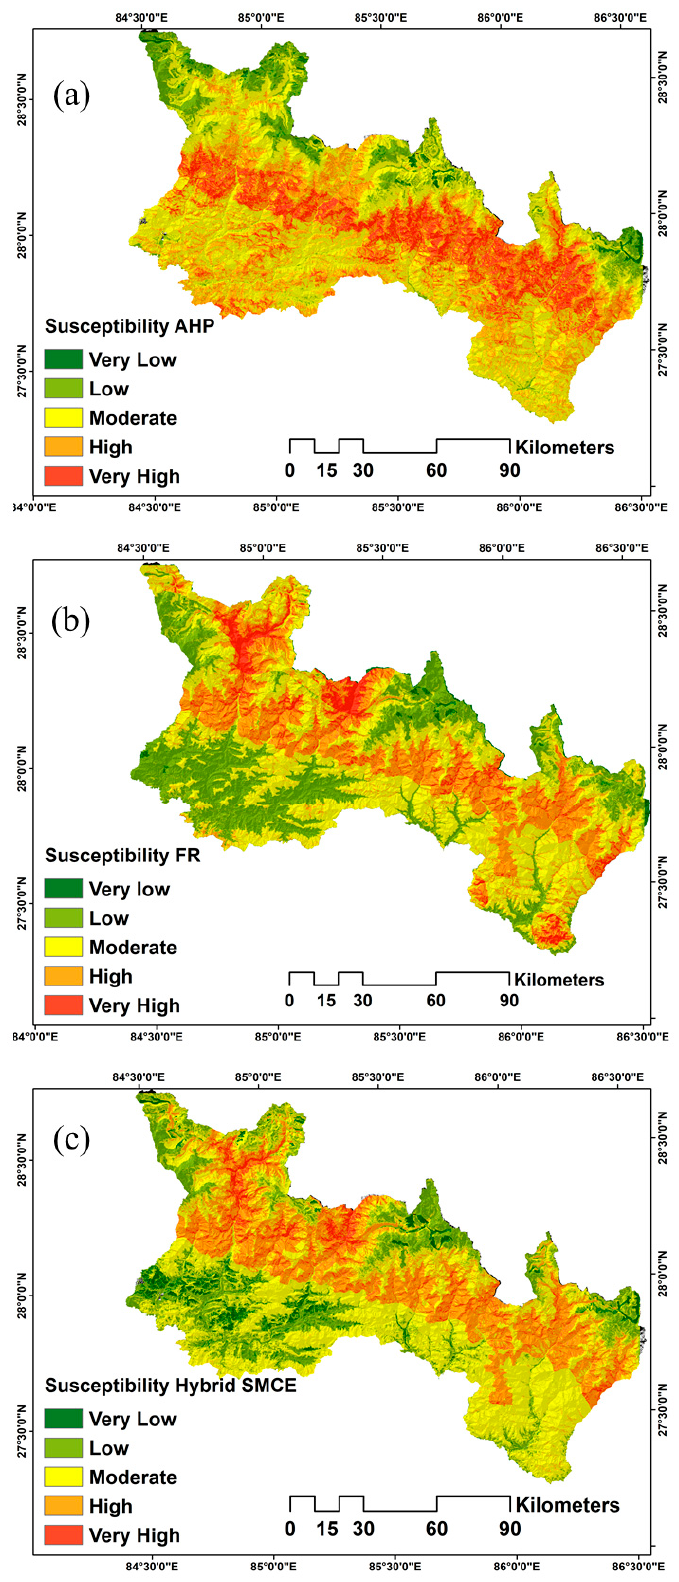
Figure 4. Output landslide susceptibility maps for each model; ( a ) analytical hierarchy process (AHP), ( b ) frequency ratio (FR), and ( c ) hybrid spatial multi-criteria evaluation (SMCE).